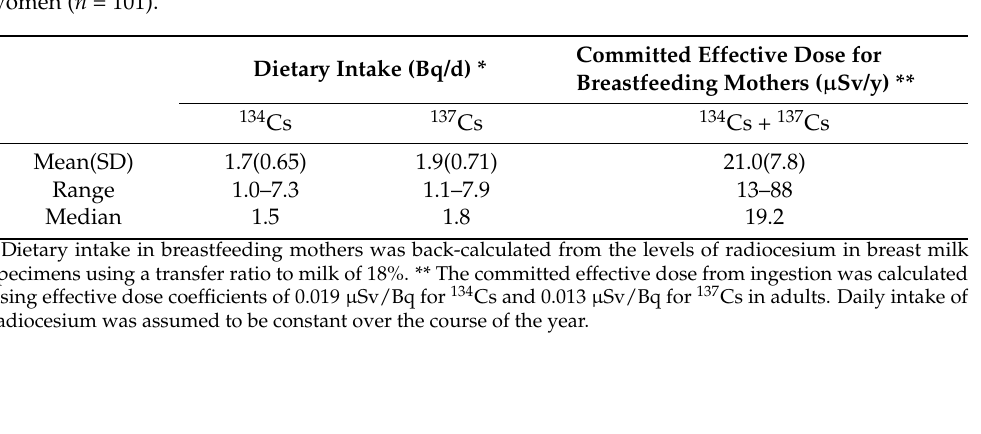
Table 4. Estimated dietary intake of radiocesium and committed effective dose in breastfeeding women ( n =